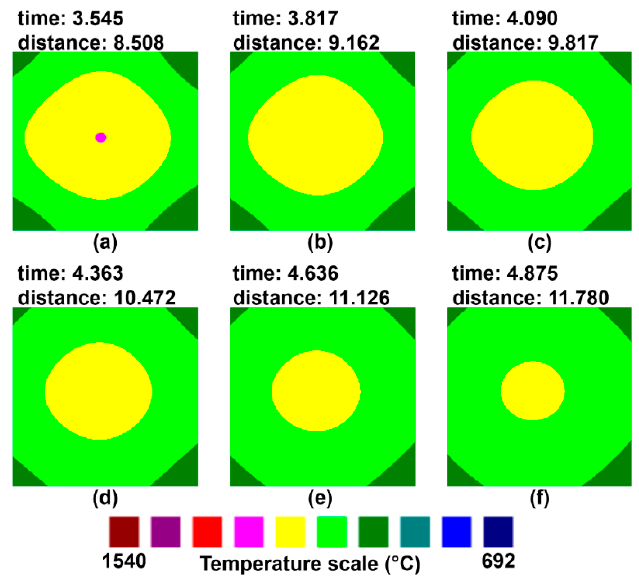
Figure 11. ( a – f ) Temperature profiles in the free zone; time (min) and distance (m).